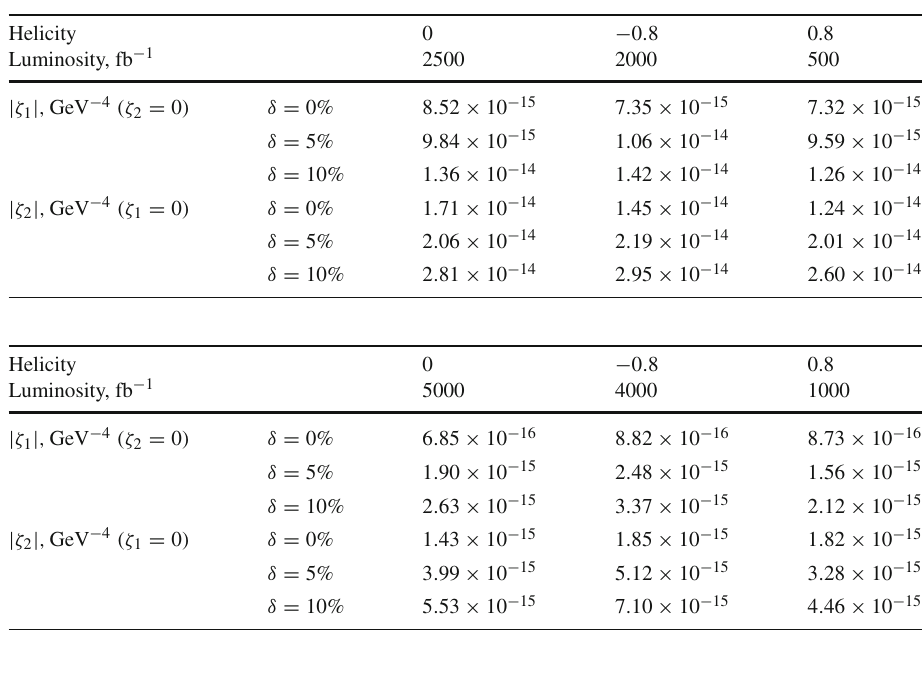
Table 2 The 95% C.L. exclusion limits on the couplings ζ